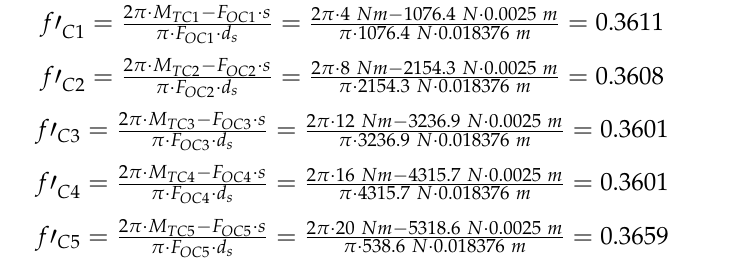
Table 4. Values determined via measurement with lubricant CX80—copper grease. No. of